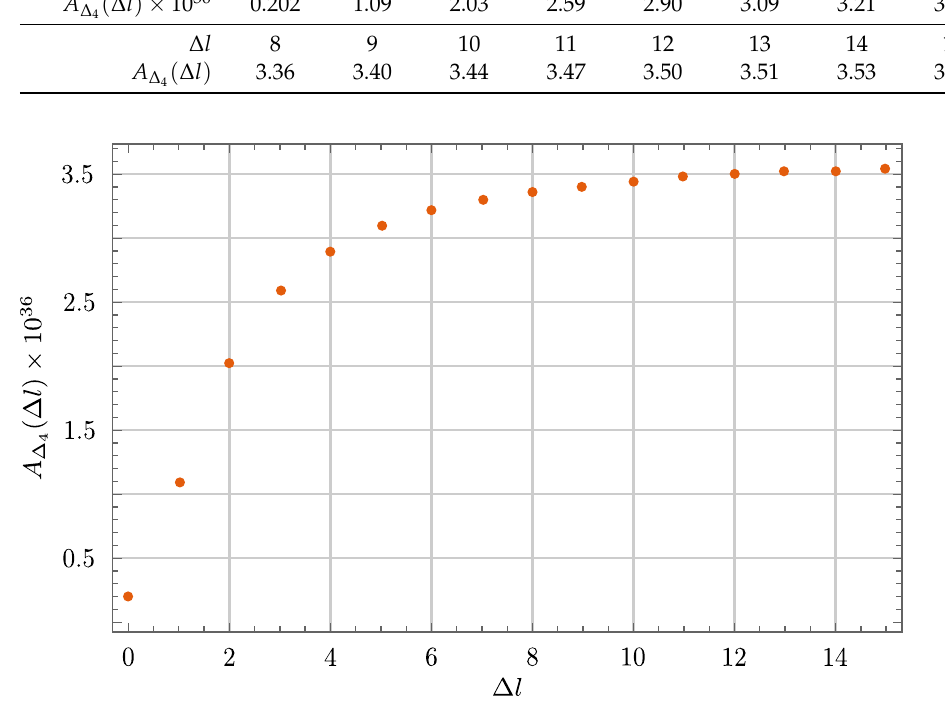
( ∆ l ) in function of the 4